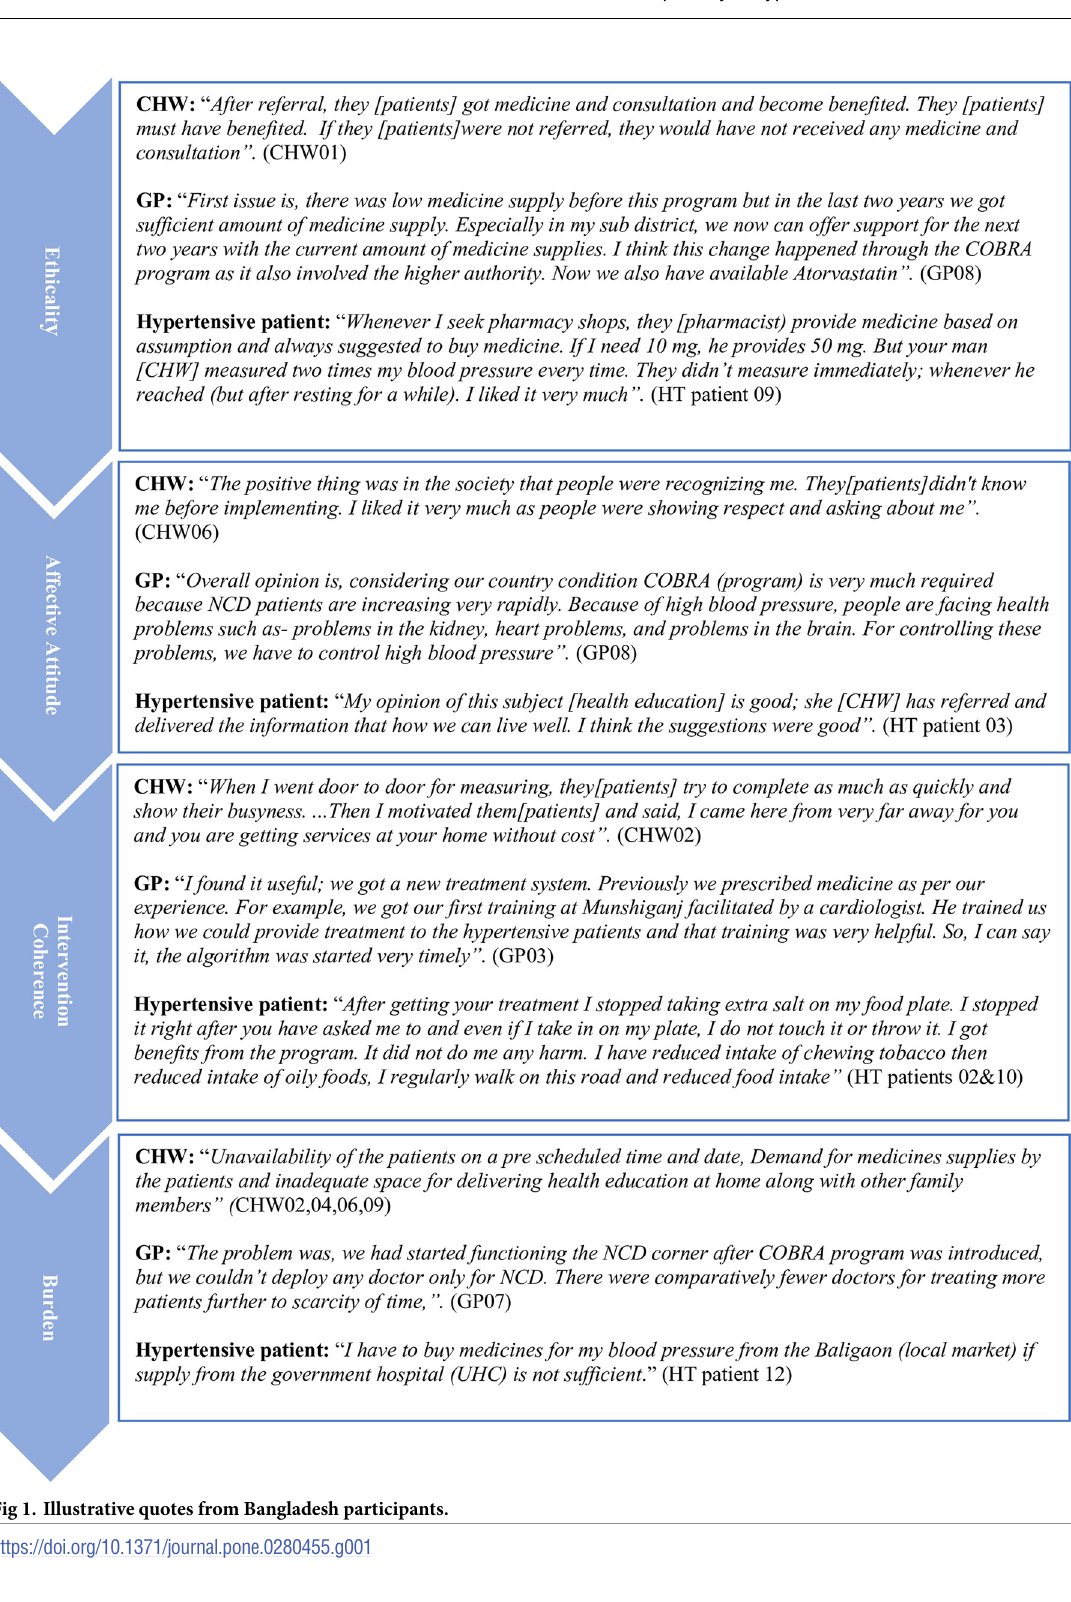
PLOS ONE | https://doi.org/10.1371/journal.pone.0280455 January 19,